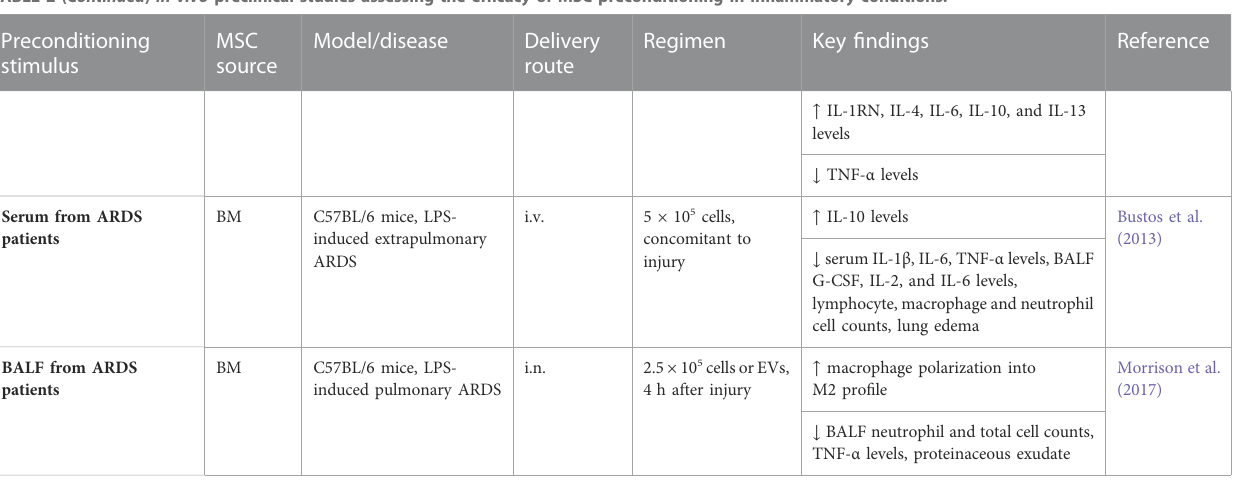
TABLE 2 ( Continued ) In vivo preclinical studies assessing the ef fi cacy of MSC preconditioning in in fl ammatory